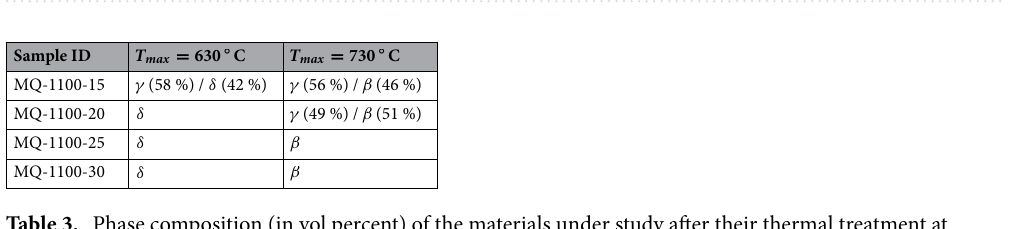
Figure 3. Room temperature XRD patterns of samples after their heat-treatment at 630 C (bottom). β , δ and γ - Bi 2 O 3 reference patterns (ICDD cards no. 04-008-4464, 04-015-0028 and 04-007-2465, respectively) are given in the bottom.